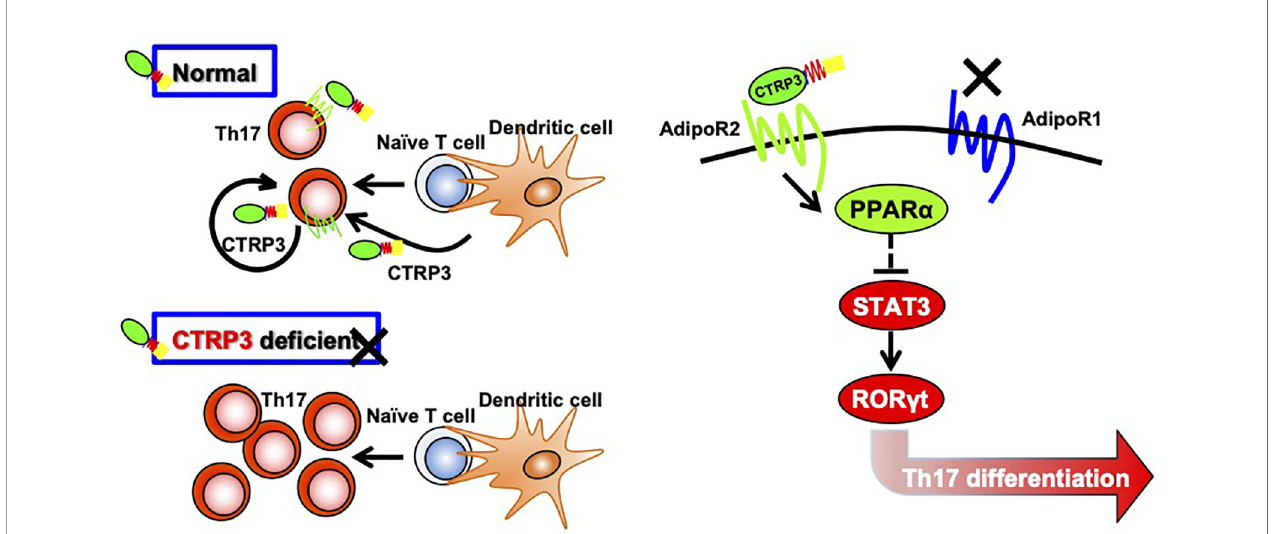
FIGURE 5 | Regulation of Th17 cell differentiation by CTRP3 through AdipoR2. CTRP3 mainly expressed in dendritic cells and Th17 cells regulates Th17 cell differentiation through activation of AdipoR2, but not via AdipoR1. The CTRP3/AdipoR2 axis enhances PPAR a expression and inhibits STAT3 and ROR g t